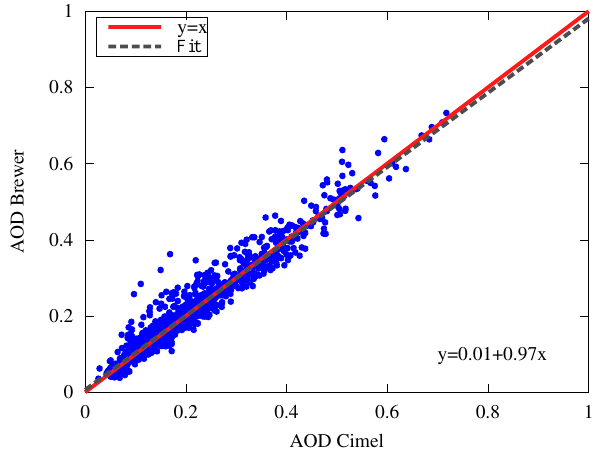
Figure 5. ETCs retrieved by transfer from the Cimel to the Brewer at slit 3. Dots identify estimates from near-simultaneous pairs of measurements, squares represent monthly averaged values.